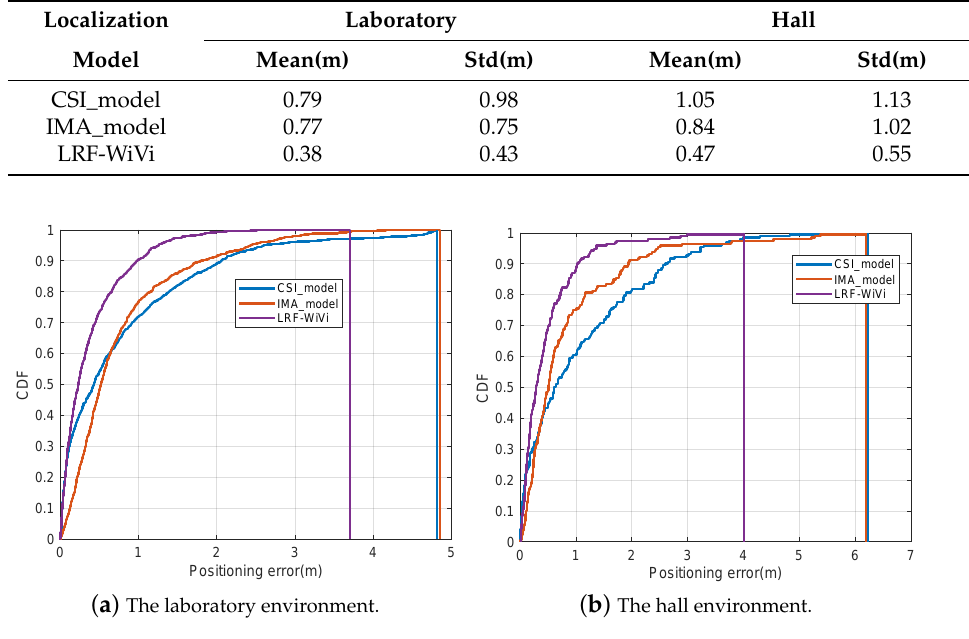
Figure 11. Comparison of positioning errors distribution with single-source